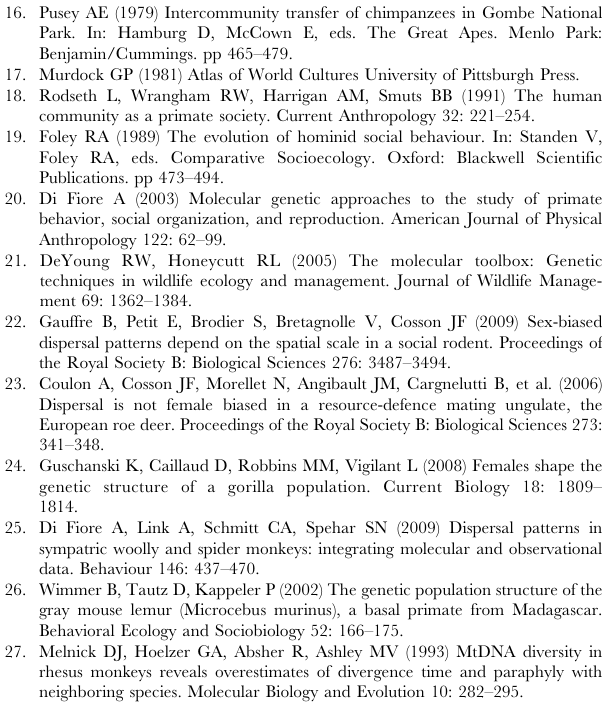
Table S3 Pairwise autosomal genetic differentiation (F ST ) in western chimpanzee (A) and bonobo (B) groups. Comparisons among males are presented below the diagonal, and among females above the diagonal, with sample sizes in brackets. Significantly differentiated pairs ( p , 0.05) are shown in bold. To minimize stochasticity, for all analyses of genetic differentiation between communities we excluded social groups with fewer than four individuals genotyped at the respective marker (autosomal/Y- chromosomal). Therefore, the number of pairwise comparisons differs between the autosomal and Y-chromosomal data (Table S5). Bonobo group C3 was only genotyped at Y-chromosomal markers [61] and is therefore not included here. Table S4 Y-chromosomal microsatellite haplotypes of bonobo and western chimpanzee males. Locality indicates sampling locations as shown in Figure 1. Individual Y-haplotypes at a locus are given as number of repeat units. Empty cells indicate missing values. Locus DYS588 and DYS562 did not amplify in bonobos, locus DYS632 was only typed in a few individuals, thus data for these loci are not used here. N, number of individuals sharing the Y-haplotype; n.a., not analyzed; a , Y-chromosomal loci DYS; b , Indel, coded as highest repeat number due to insufficient knowledge of mutational pattern. Table S5 Pairwise Y–chromosomal genetic differentia- tion (F ST ) in western chimpanzee (A) and bonobo (B) groups. Significantly differentiated pairs ( p , 0.05) are shown